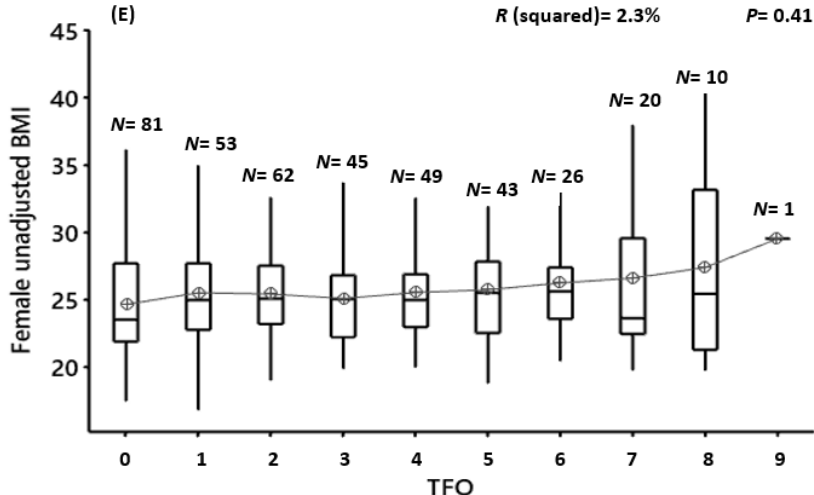
Figure 4. Female unadjusted BMI vs. the frequency of food outlet usage for 7-consecutive days. ( A ) FSR = full-service restaurant, ( B ) FFR = fast-food restaurant, ( C ) delivery, ( D ) take-away and ( E ) TFOs = total food outlets, N = number of participants in each group. Results of the ANOVA are shown. Significance is where p < 0.01 (after Bonferroni correction).